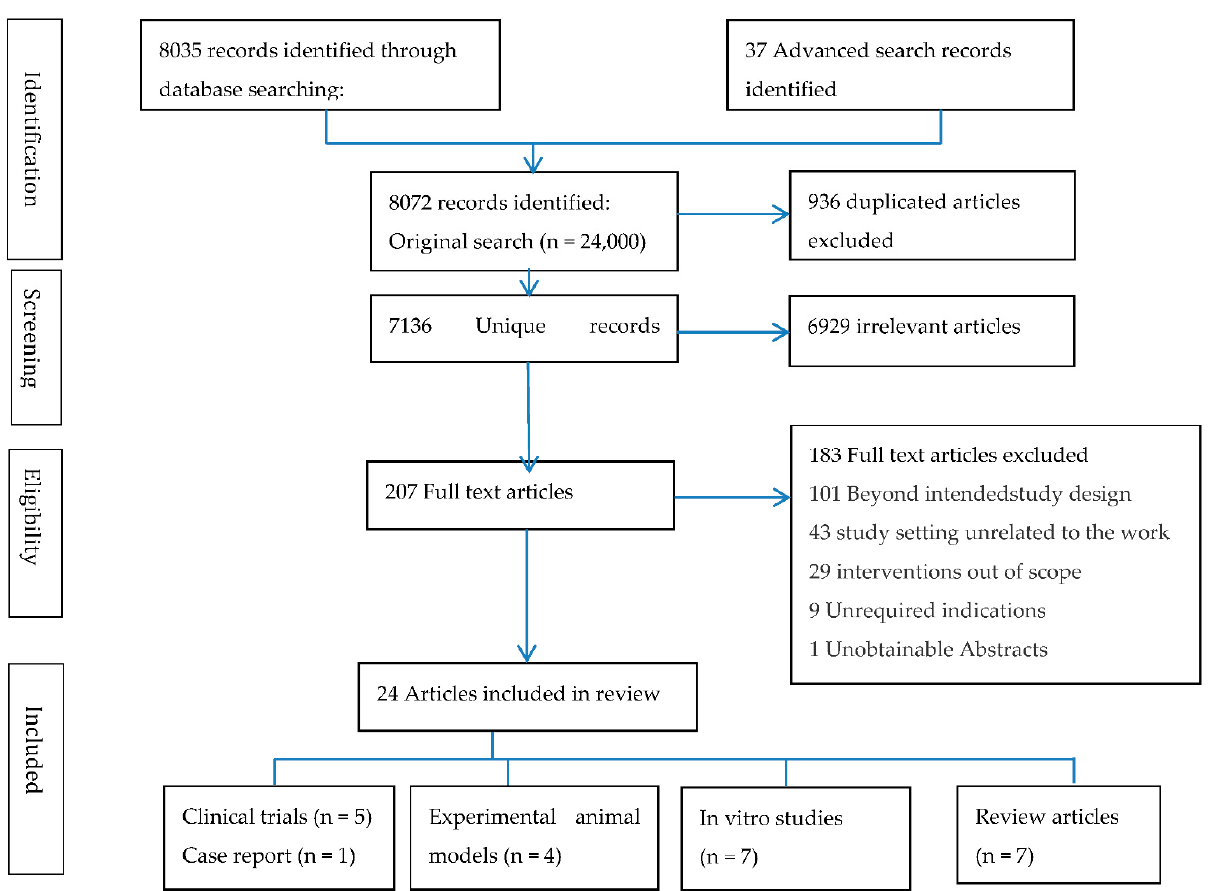
Figure 1. PRISMA flowchart of study selection process.